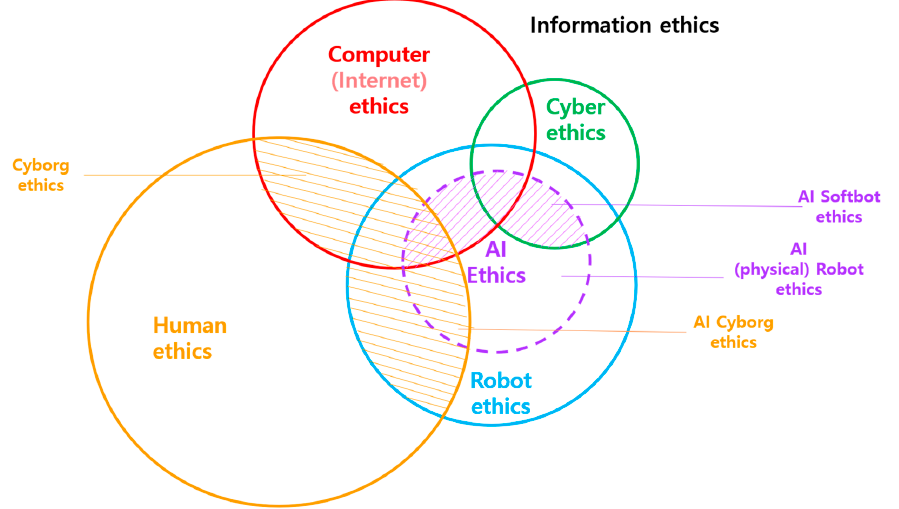
Figure 2. Framework for information ethics illustrating the union of computer (internet) ethics, cyber ethics, and robot ethics with human ethics.